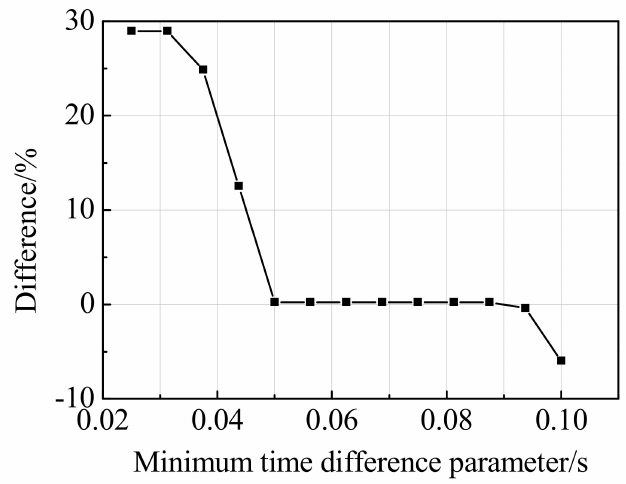
Figure 12. The di ff erence of results of train speed estimation with di ff erent minimum time di ff erence parameters.